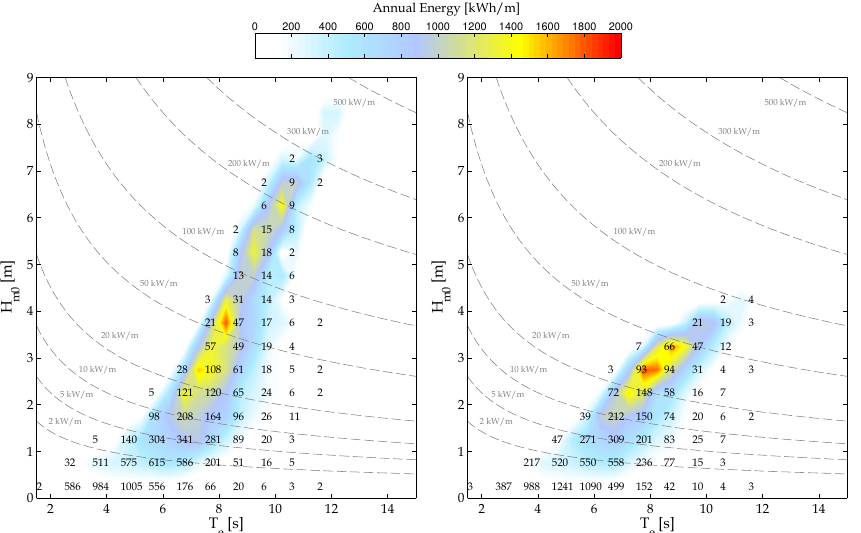
Figure 13. Characterisation of the yearly average wave energy in terms of H m 0 and T e : on the left site HS3 and on the right site HS4. The colour scale represents annual energy per metre of wave front (in MWhm − 1 ). The numbers within the graph indicate the occurrence of sea states (in number of hours per